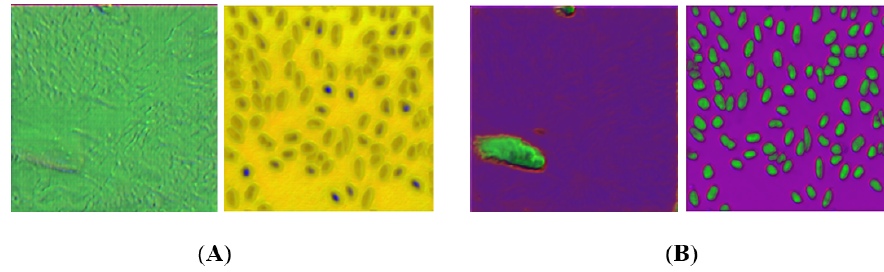
Figure 6. ( A ) RGB images reconstructed from the layer before the last network layer ( i.e., from 16 feature maps) without metric learning; ( B ) RGB images reconstructed from the last network layer with metric learning (triplet loss with semi-hard mining). RGB channels were selected randomly from the 16 feature maps from the layer before the last layer of the